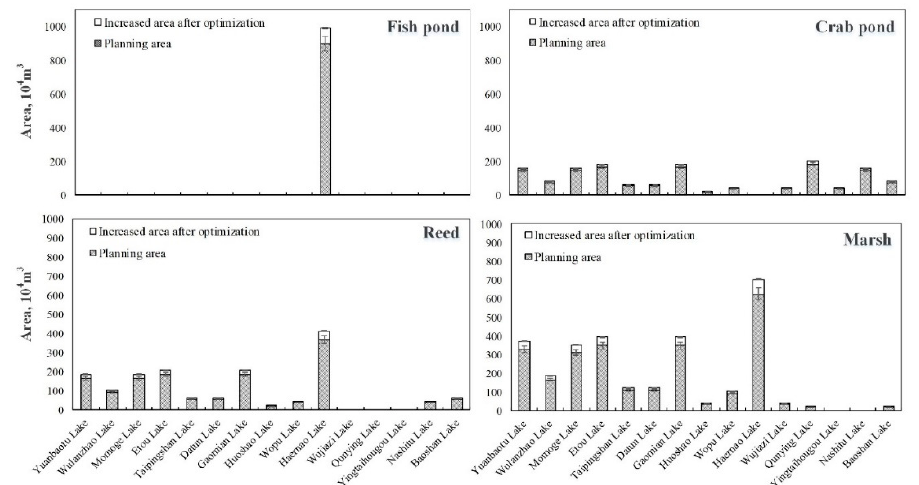
Figure 7. The area of each ecological functional area of the lakes at high flow level (the shaded part is the planned value; the blank part is the added value after optimization).